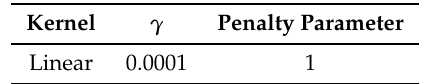
Table 3. Hyperparameters tuning for SVM as a multi-Label classifier.